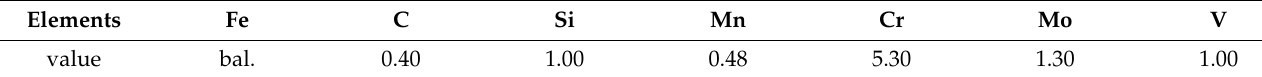
Figure 2. SEM image showing the morphology of H13 powder. Table 1. Chemical composition of steel H13 (wt%), according to the delivery certificate. Elements